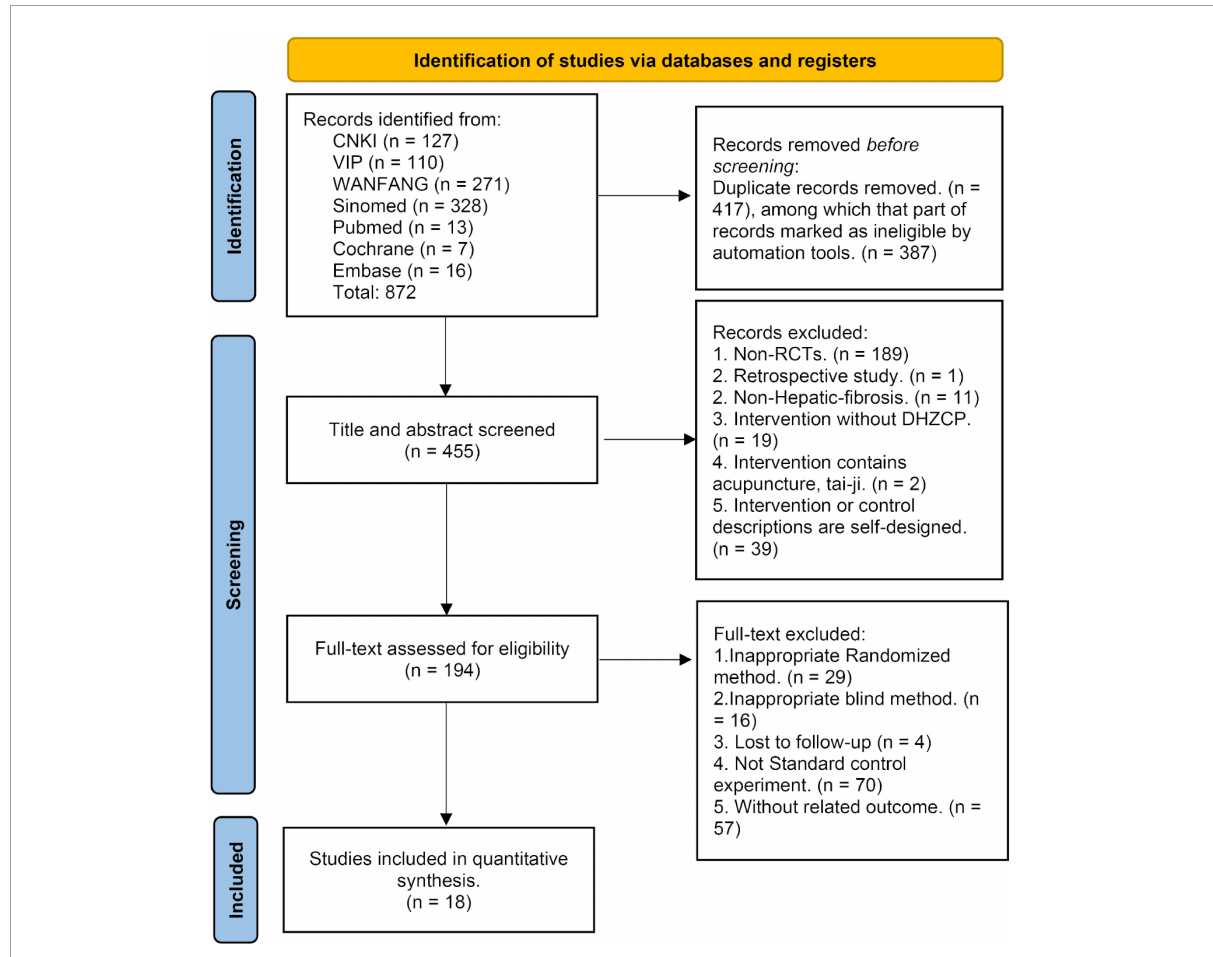
FIGURE1 The literature research result [Preferred Reporting Items for Systematic Reviews and Meta-Analyses (PRISMA) flow